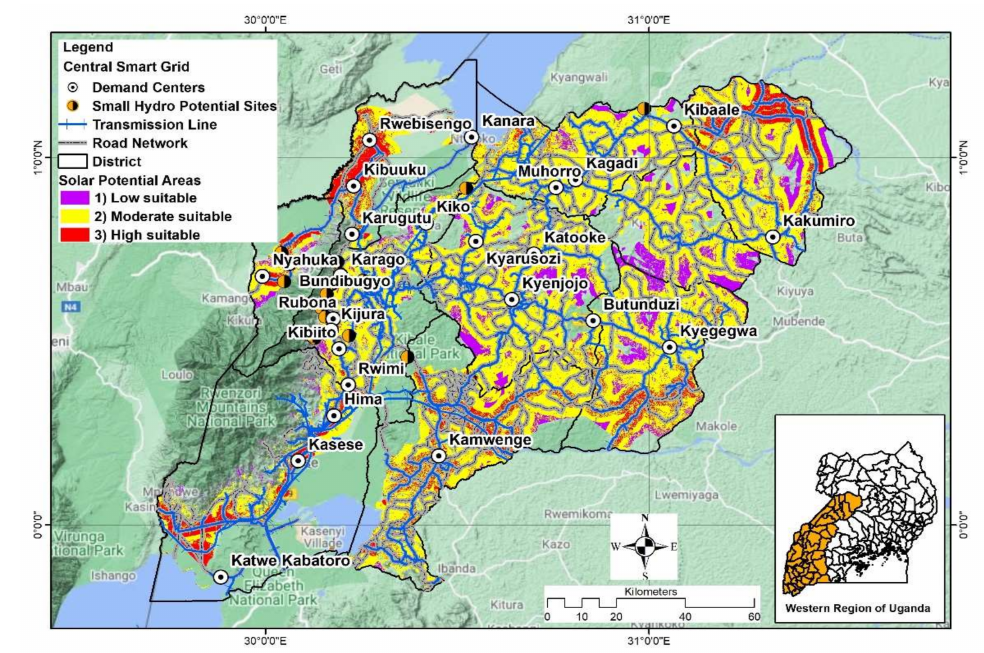
Figure 19. Final map of Central smart grid suitability